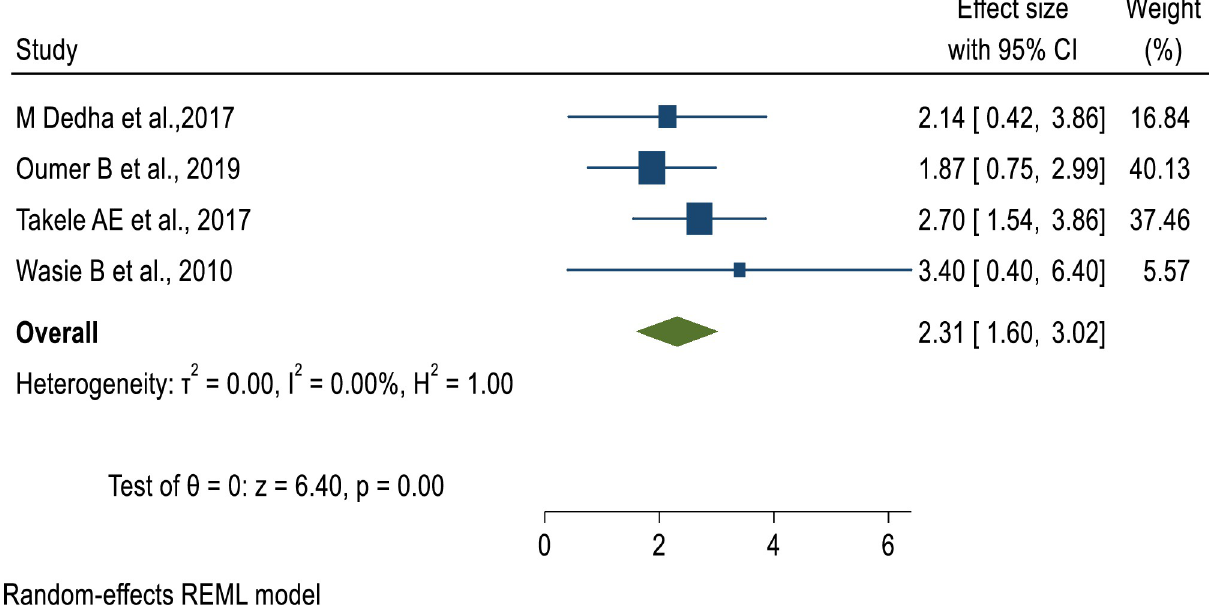
Fig 8. Pooled effect of “ART duration” on undernutrition among adult PLWHIV in sub-Saharan Africa, 2021.